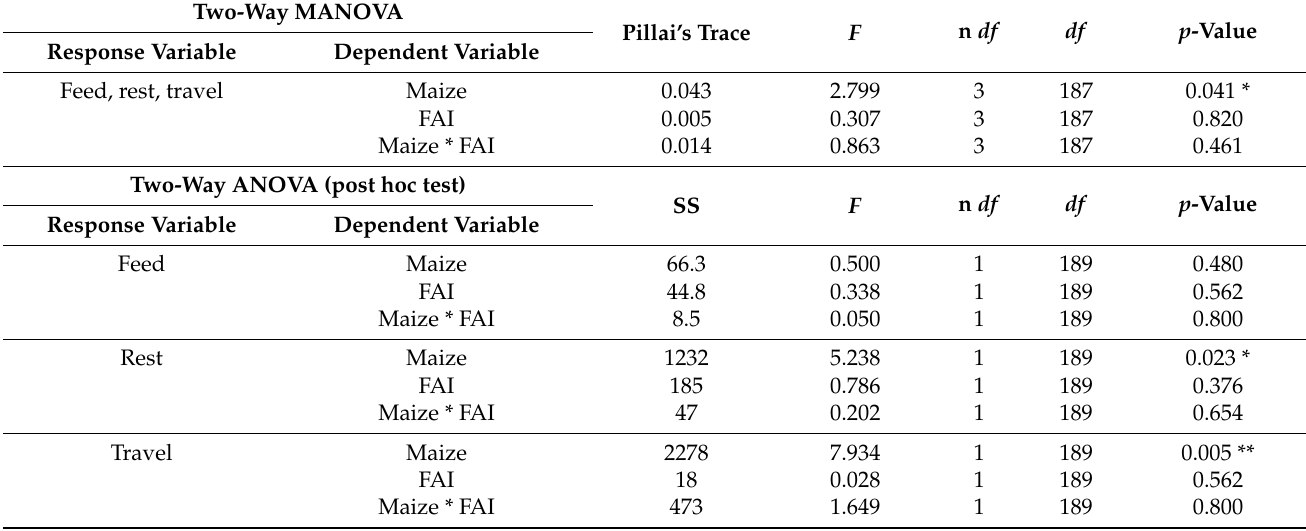
Table 5. Results of two-way MANOVA and two-way ANOVA for the activity